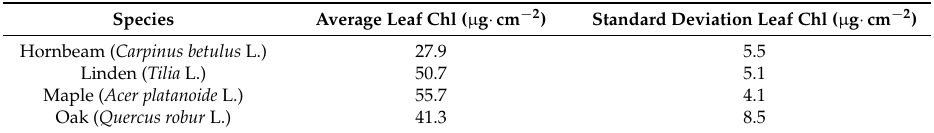
Table 2. Average and standard deviation of leaf chlorophyll concentration ( µ g ¨ cm ´ 2 ) extracted for Hornbeam ( Carpinus betulus L.), Linden ( Tilia L.), Maple ( Acer platanoide L.) and Oak ( Quercus robur L.). Species Average Leaf Chl ( µ g ¨ cm ´ 2 ) Standard Deviation Leaf Chl ( µ g ¨ cm ´ 2 ) Hornbeam ( Carpinus betulus L.)